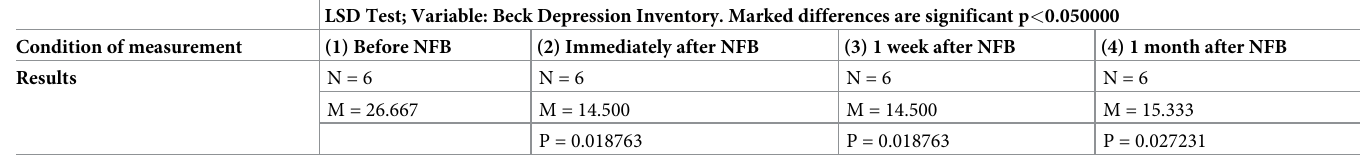
The following table depicts p values for difference between pre-to-post NFB data for score for Beck Depression Inventory. Abbreviation LSD stands for Least Significance Difference. M stands for mean value. N indicates number of tested participants for the particular variable. P stands for p value. Numbers in the brackets mean the following: (1) means data before NFB, (2) means data immediately after NFB, (3) means data 1 week after NFB and (4) means data after 1 month after